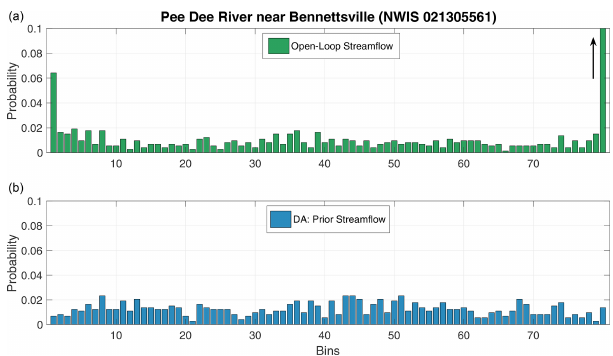
Figure 13. Rank histograms for the open-loop and the prior stream- flow obtained at Pee Dee River near Bennettsville. The histograms have been normalized to show probability instead of the observa- tion count. The arrow in the last bin of panel (a) indicates that the probability is large ( ∼ 0 .